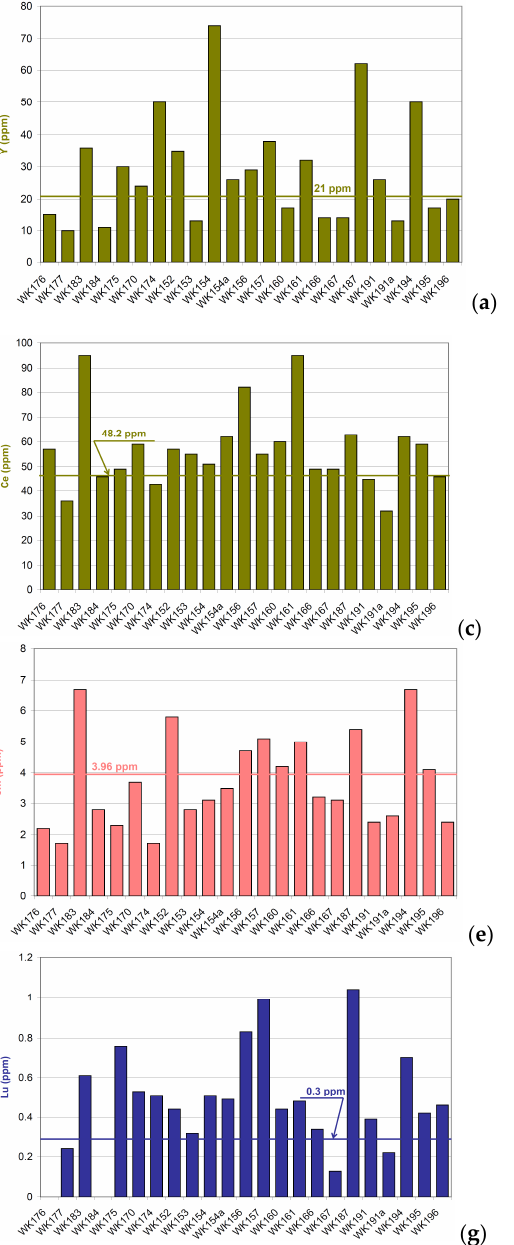
Figure 4. Graphics of grades ( a ) barium—Ba, ( b ) potassium—K, ( c ) lithium—Li, ( d ) phosphorus—P, ( e ) rubidium—Rb, ( f ) scandium—Sc, ( g ) strontium—Sr, ( h ) thorium—Th, ( i ) uranium—U, ( j ) vanadium—V.